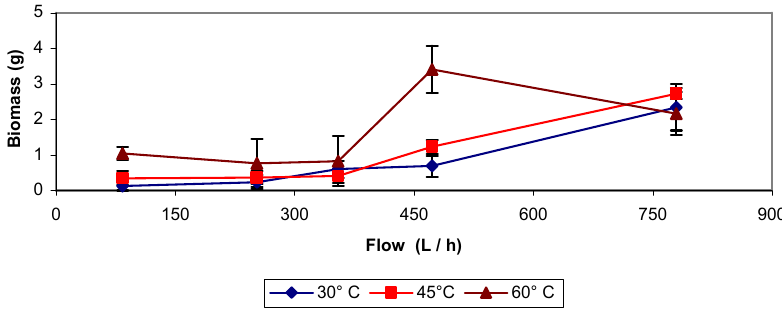
Figure 12. Air sparging applied at different temperatures and flow